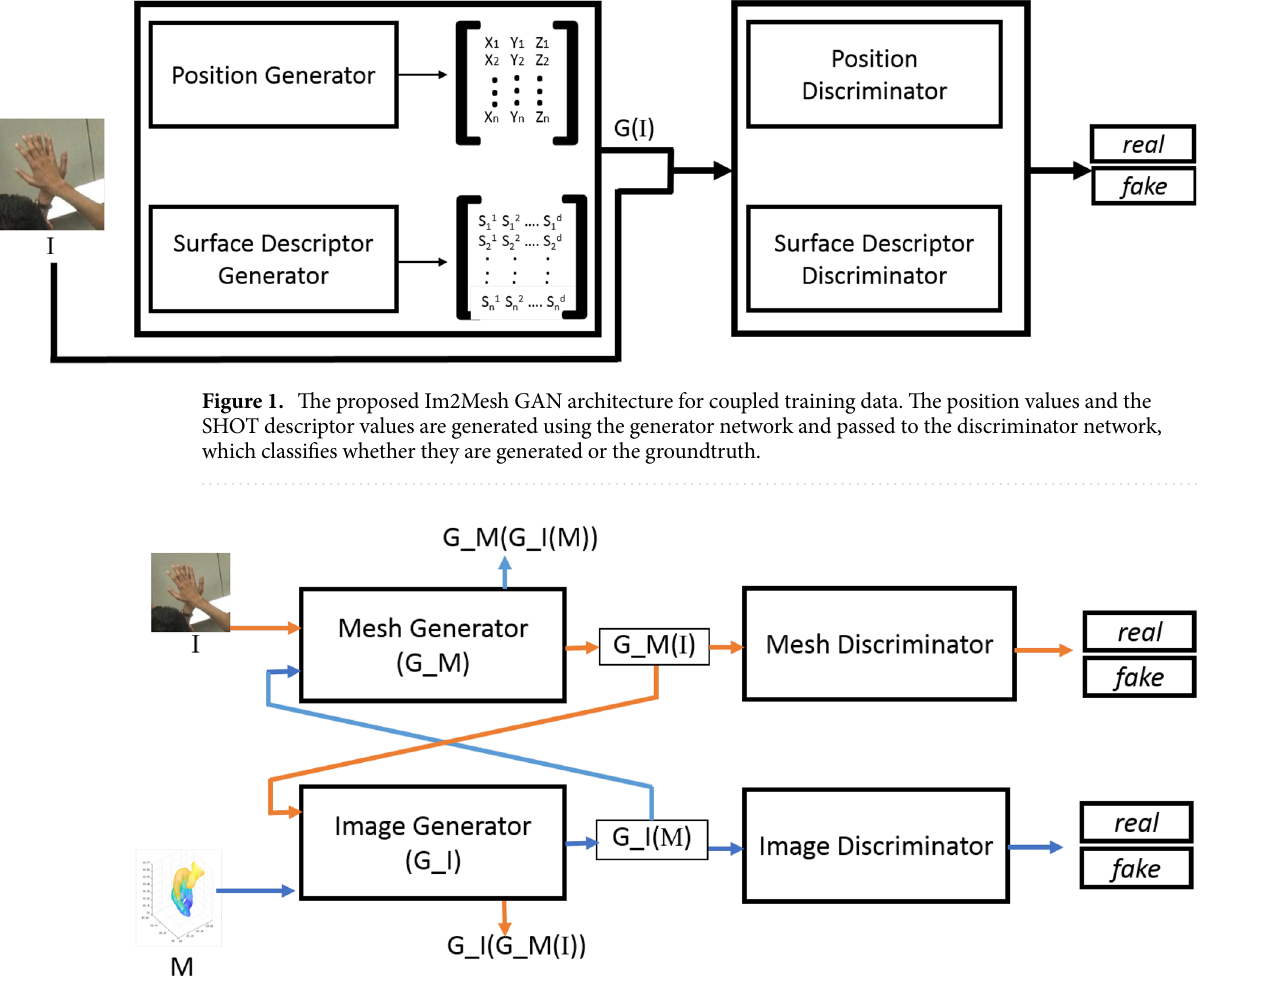
Figure 2. The proposed Im2Mesh GAN architecture for uncoupled training data. G _ M denotes the generator which is designed for estimating the mesh from the input image I , where as G _ I denotes the generator which is designed for estimating the image from the input mesh M